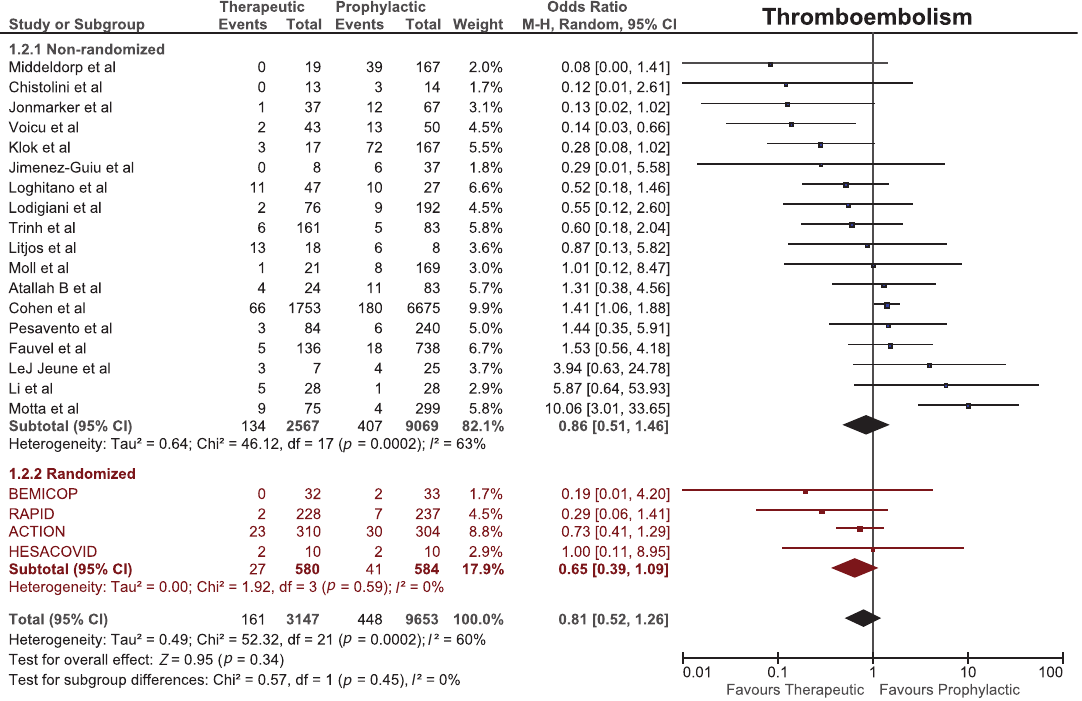
TH Open Vol. 6 No. 4/2022 © 2022. The